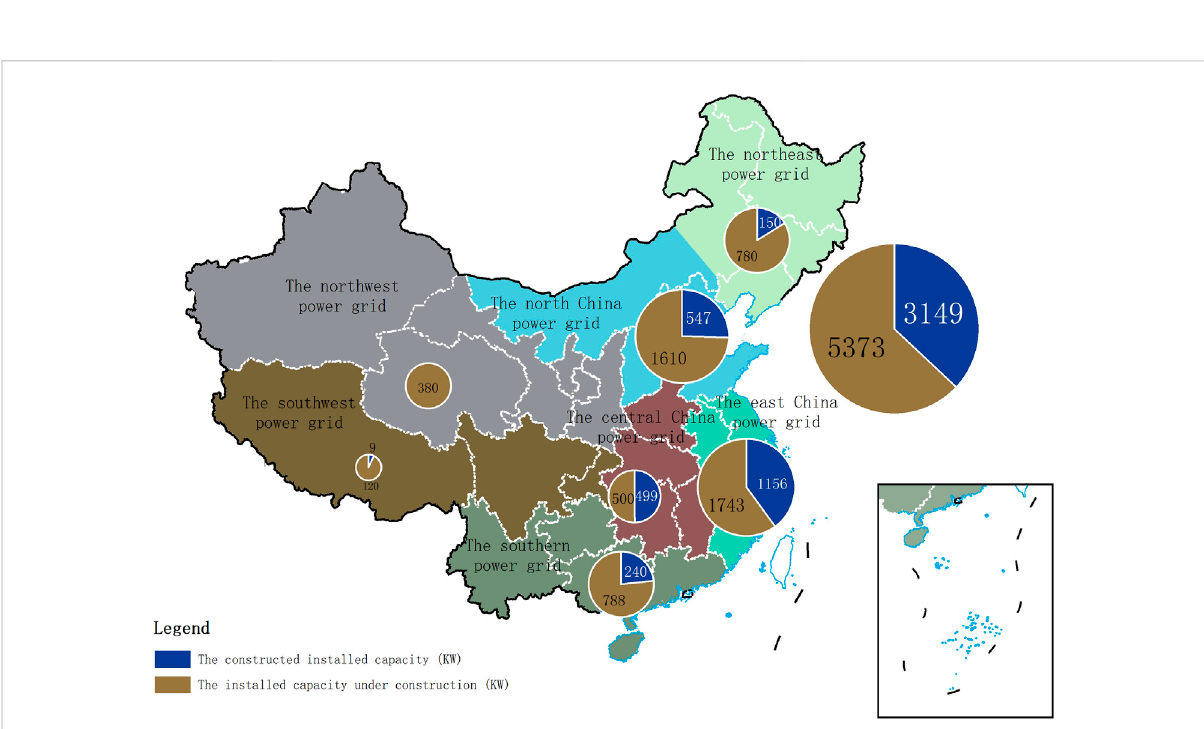
FIGURE 11 Existing installed capacity of PSPS in